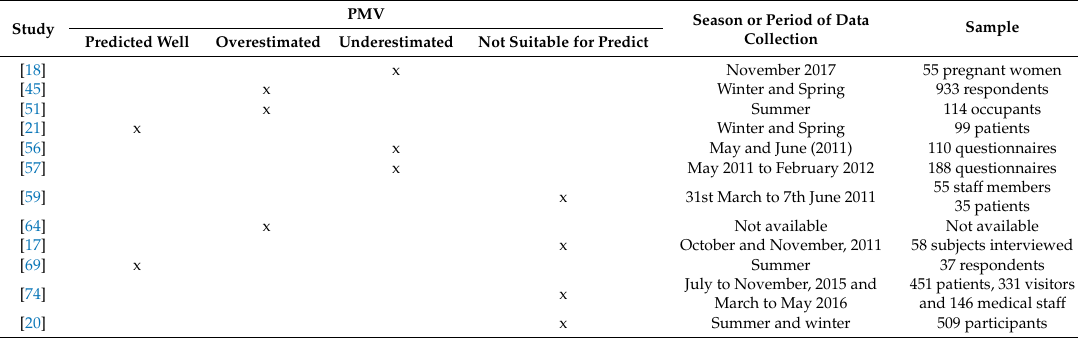
Table 8. Discrepancies between predicted mean vote (PMV) and thermal sensation vote